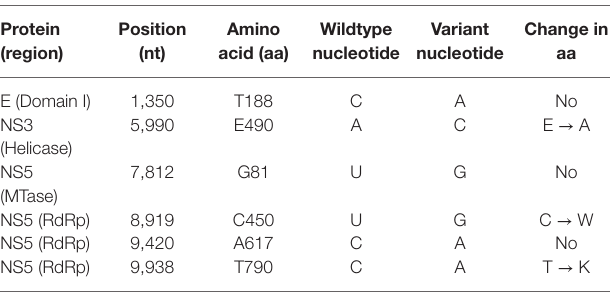
TABLE 1 | Mutations and amino acid substitutions at the six